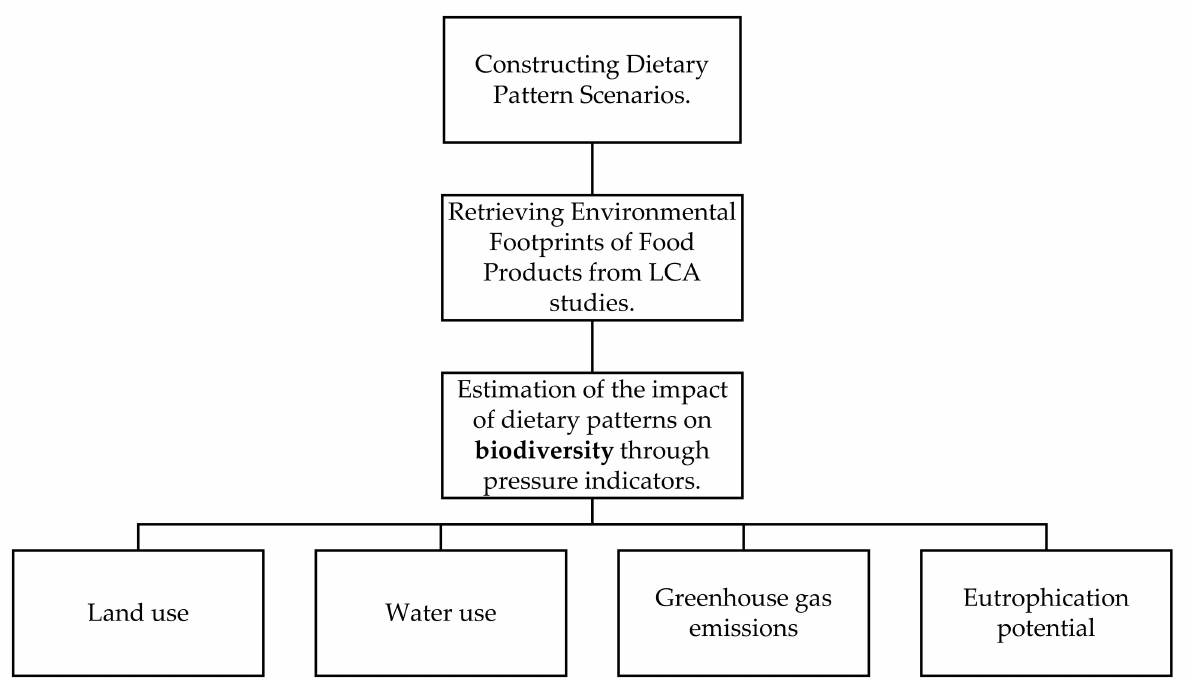
Figure 1. Graphical scheme of design